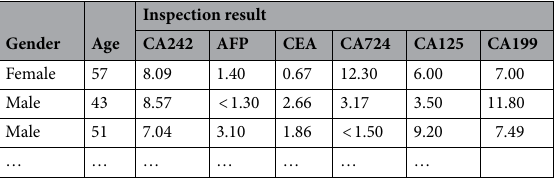
Table 1. Sample of the original dataset.